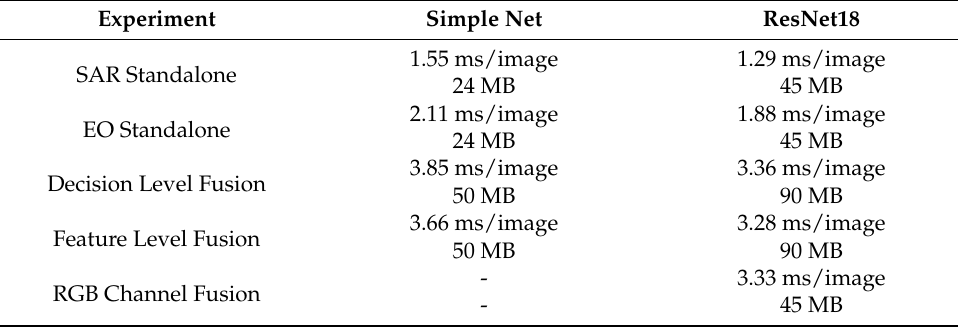
Table 11. Calculation times and network storage